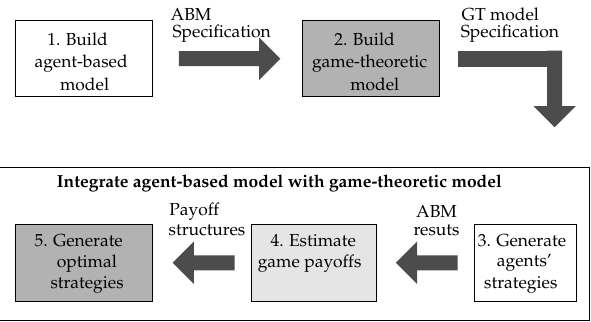
Figure 2. Step by step methodology followed in this work. Note: ABM refers to agent-based modeling and GT refers to game theory. Dark gray boxes correspond to the GT model (Step 2 and 5). White boxes correspond to the agent-based model (Step 1 and 3). The light gray box represent the interaction between the agent-based model results and the game-theoretic payoff